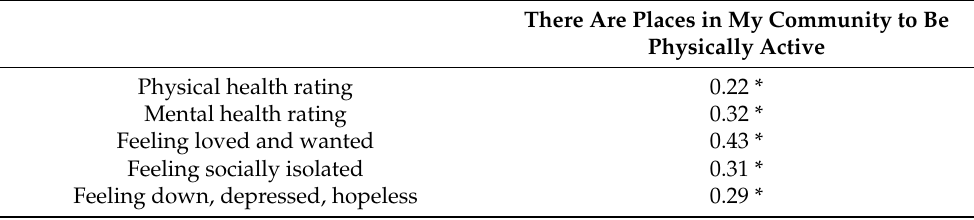
There Are Places in My Community to Be Physically Active 0.46 *